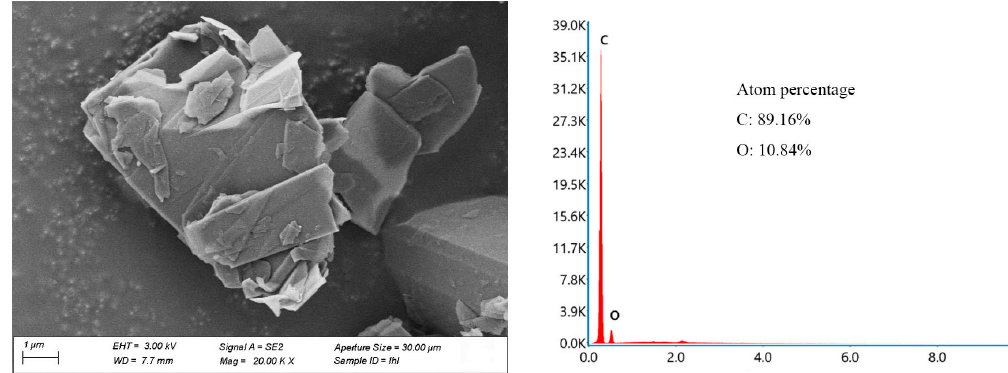
Figure 2. EDS (Energy dispersive spectrometer) morphology of graphite powders.